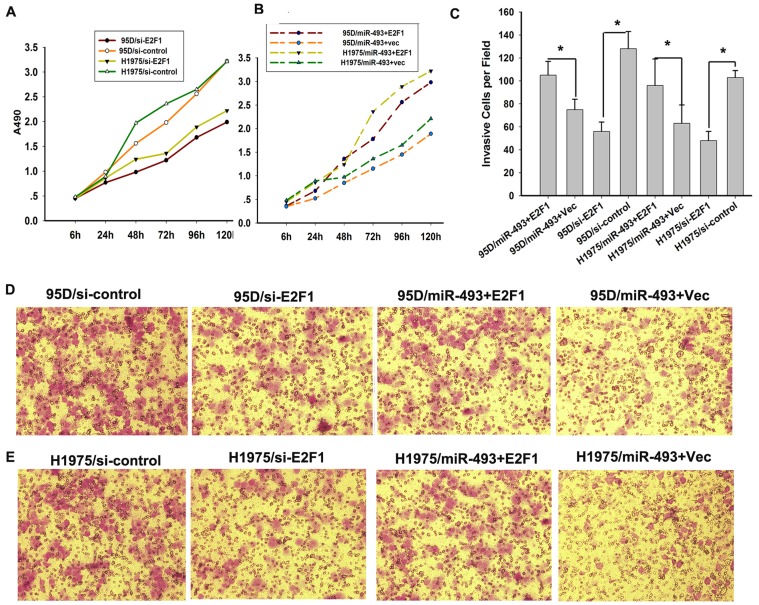
miR-493 inhibits the proliferation and invasion of lung cancer cells by targeting E2F1.A, The knock-down of E2F1 partly simulated the suppression lung cancer cells growth induced by the overexpression of miR-493 in 95D and H1975 cells. The growth curves demonstrated the capability of lung cells proliferation. The absorption value of cells was measured at the indicated time points in triplicate and their growth rates were recorded. B, Overexpression of exogenous E2F1 (without 3′-UTR of E2F1) rescued upon the proliferation suppression induced by miR-493 in 95D and H1975 cells. C, T The invasive properties of H1975 and 95D cells which were either knock-down or overexpression of E2F1were analyzed with a transwell assay using a Matrigel-coated chamber. The migrated cells were plotted as the average number of cells per field of view from 3 different experiments, as described in the Materials and Methods. The data are the mean ± SD.* means p<0.05. D and E, Representative images of the assays are shown. Original magnification: ×200.